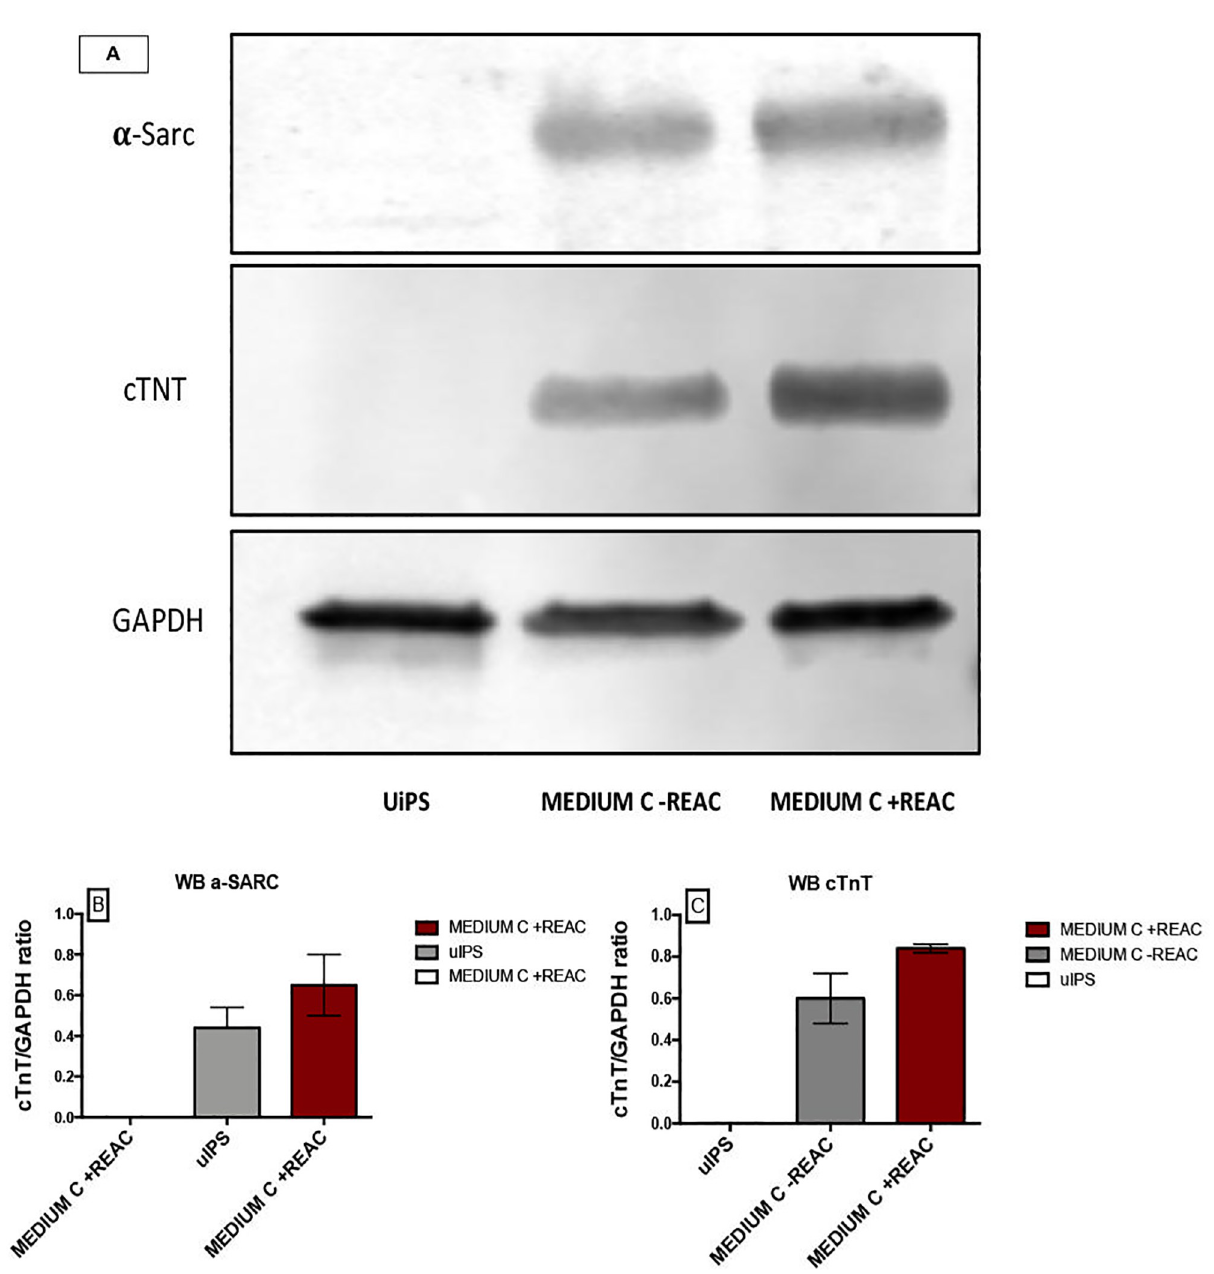
Fig 6. Effect of REAC treatment on the expression of cardiogenic markers in hUiPSCs after 14 days. Total lysates were isolated from hUiPSCs committed by Cardiogenic medium (Medium C) in the absence or presence of REAC treatment for 72 hours. Samples were analyzed by Western blot, using antisera against α -Sarcomeric actinin ( α -Sarc), cardiac troponin T (cTNT) and GAPDH (A). The sizes of the bands were determined using prestained marker proteins. The data presented are representative of five separate experiments. Two different membranes were incubated with anti- mouse (cTNT, GAPDH) or anti-rabbit ( α -Sarc), densitometry analysis for α -Sarc (B) and cTnT (C) were performed with ImageJ.